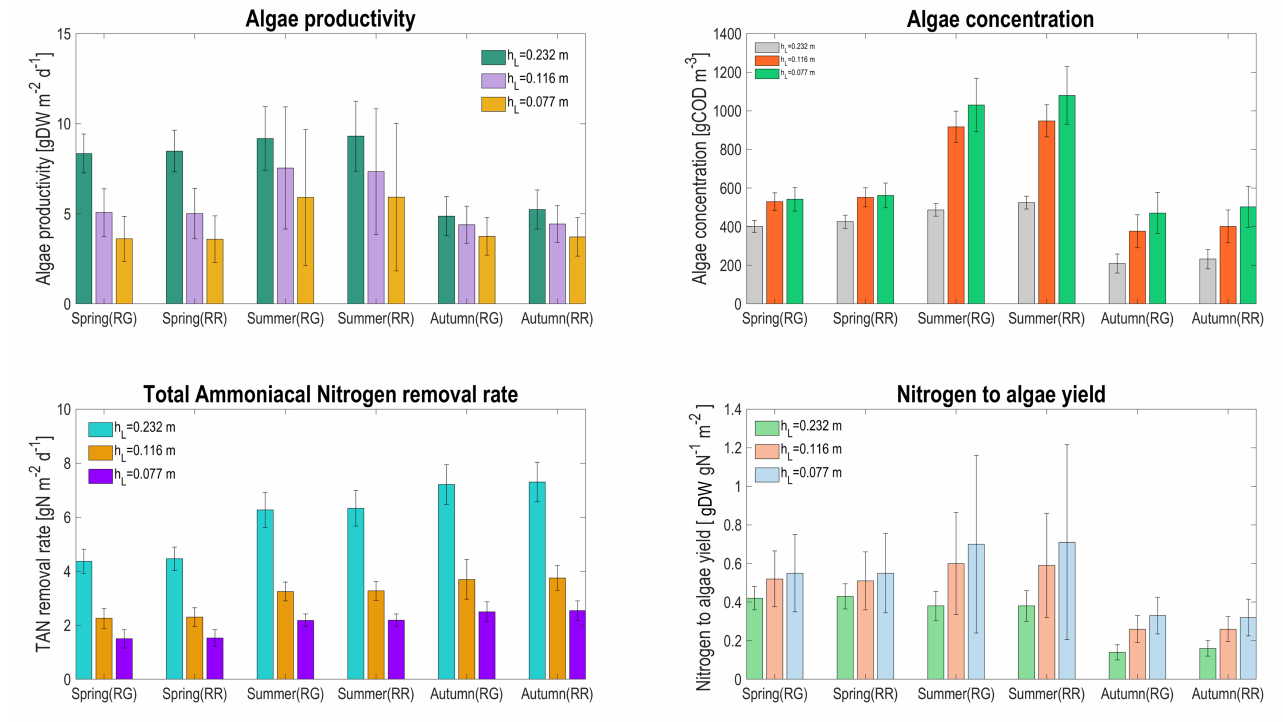
Figure 11. Seasonal average and the associated standard deviation for algal productivity, algae concentration, TAN removal rate, and nitrogen conversion rate, for the two raceway configurations (RG: raceway on the ground, RR: raceway raised) and according to the three water